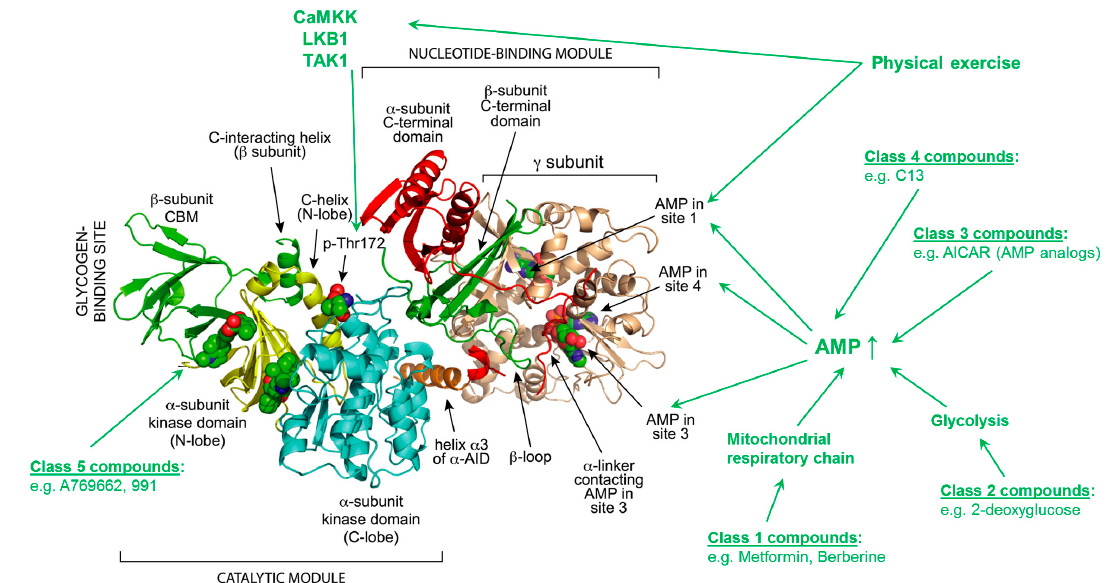
Figure 2. Structure and regulation of heterotrimeric AMPK. The model was created with MacPyMol using protein database (PDB) file 4CFE. The α , β and γ subunits are shown in “cartoon view” with domains color ‐ coded. The three bound molecules of AMP, and phospho ‐ Thr172 are shown in “sphere view” with C atoms green, O red, N blue and P orange. The different classes of compounds and their specific points of action are listed in green. Abbreviations: AICAR: